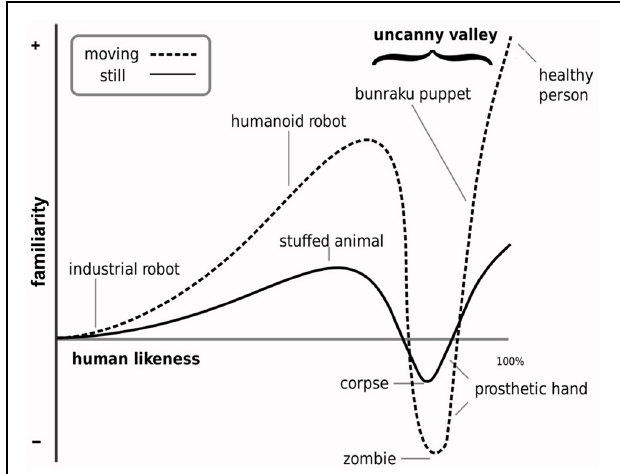
FIGURE 1 | Illustration of the Uncanny Valley Hypothesis. The main prediction of the Uncanny Valley Hypothesis is that observation of highly humanlike characters and objects (depicted along the dimension of human likeness) will evoke a sharp negative peak in affective experience (depicted along the familiarity dimension). This negative peak, referred to as the uncanny valley, is characterized by feelings of strangeness and disquiet. These feelings are suggested to be stronger for dynamic stimuli. The valley occurs at the point along the dimension of human likeness at which category membership as human or non-human is highly ambiguous (illustration adapted from MacDorman,